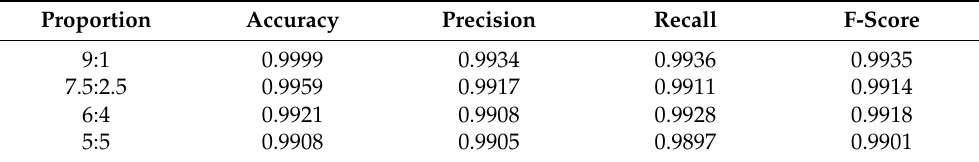
Table 3. Dividing the dataset using different division